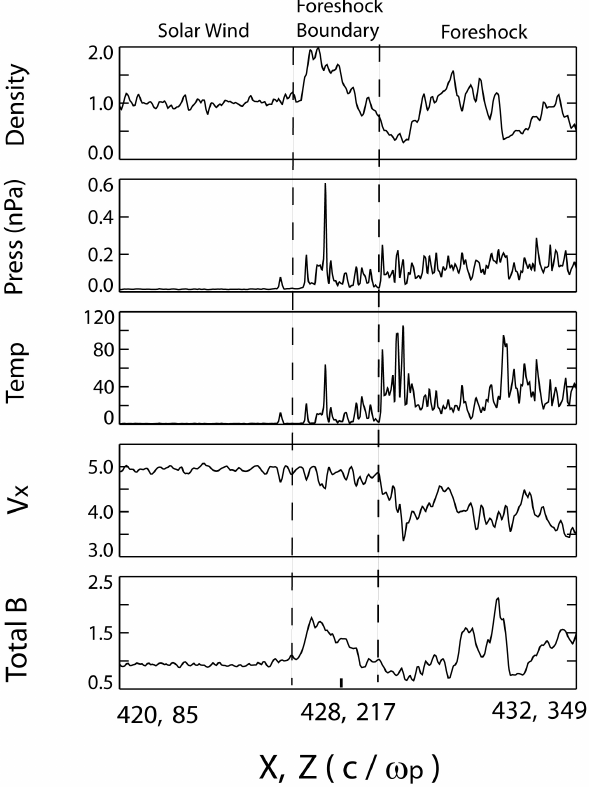
Fig. 2. Densities, velocities, temperatures, and total magnetic field strengths along the vertical cut shown in Fig. 1, from the pristine so- lar wind (on the left) to the foreshock on the right. Compared to the solar wind, the foreshock is a region of depressed, variable, den- sities, velocities, and magnetic field strengths, but enhanced tem- peratures. The boundary of the foreshock is a region of enhanced densities and magnetic field strengths.